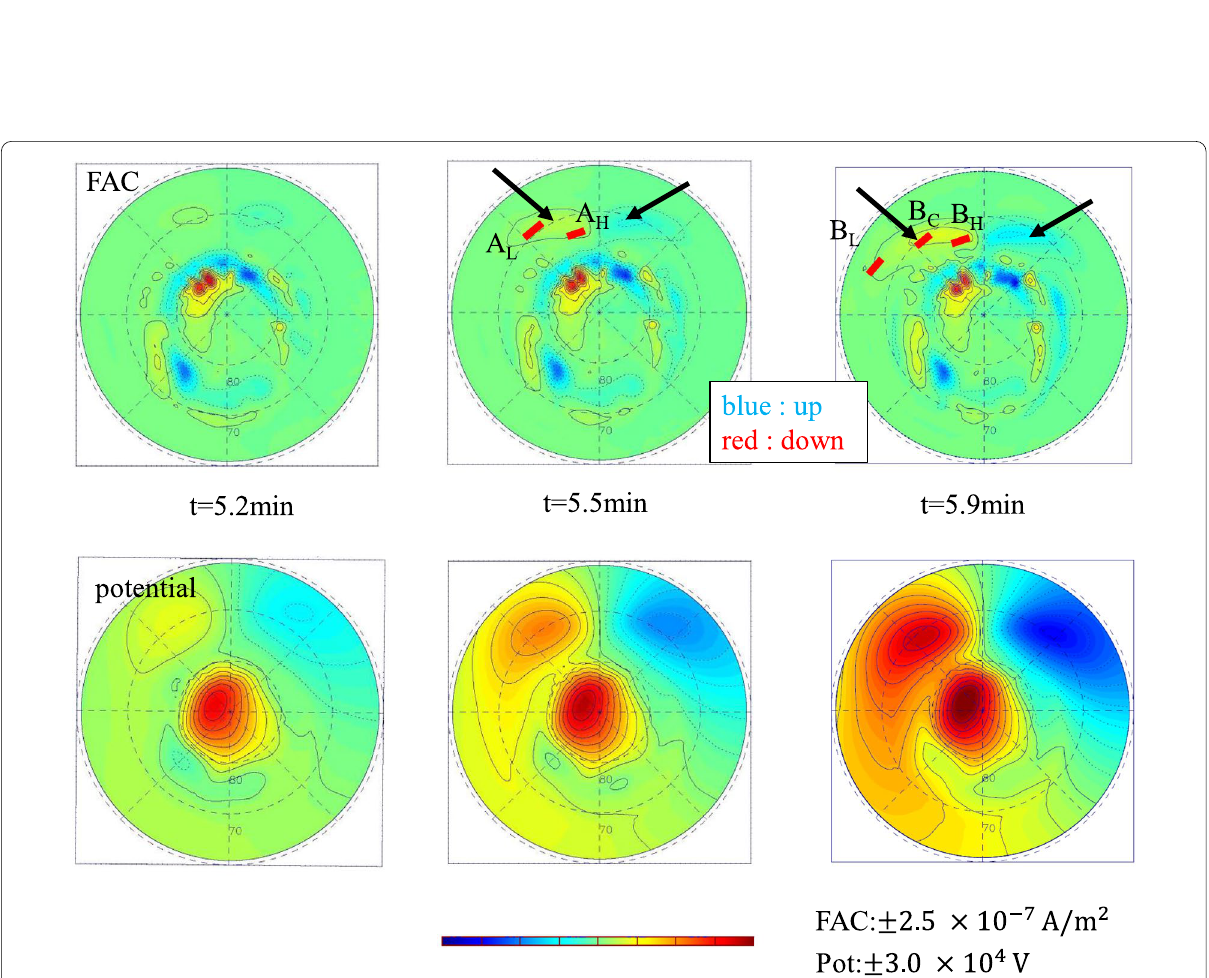
Fig. 2 (Top row) Temporal evolution of the FAC distribution in the northern hemisphere at latitudes above 60° from t 5.2 to 5.9 min. The black = arrows at t 5.5 and 5.9 min indicate the FACs of the PI. The red thick lines labeled A H and A L in the 5.5-min panel and B H , B c , and B L in the 5.9-min = panel indicate the footpoints of the current systems shown in Figs. 3 and 4. The latitude and MLT of these footpoints are as follows: A H (75.5°, 12.6– = 13.1 MLT); A L (69.1°, 14.0–14.8 MLT); B H (73.6°, 12.6–13.1 MLT); B C (71.3°, 13.8–15.0 MLT); B L (65.9°, 16.2–16.8 MLT). (Bottom row) Temporal = = = = evolution of the electric potential distribution for the same region and time